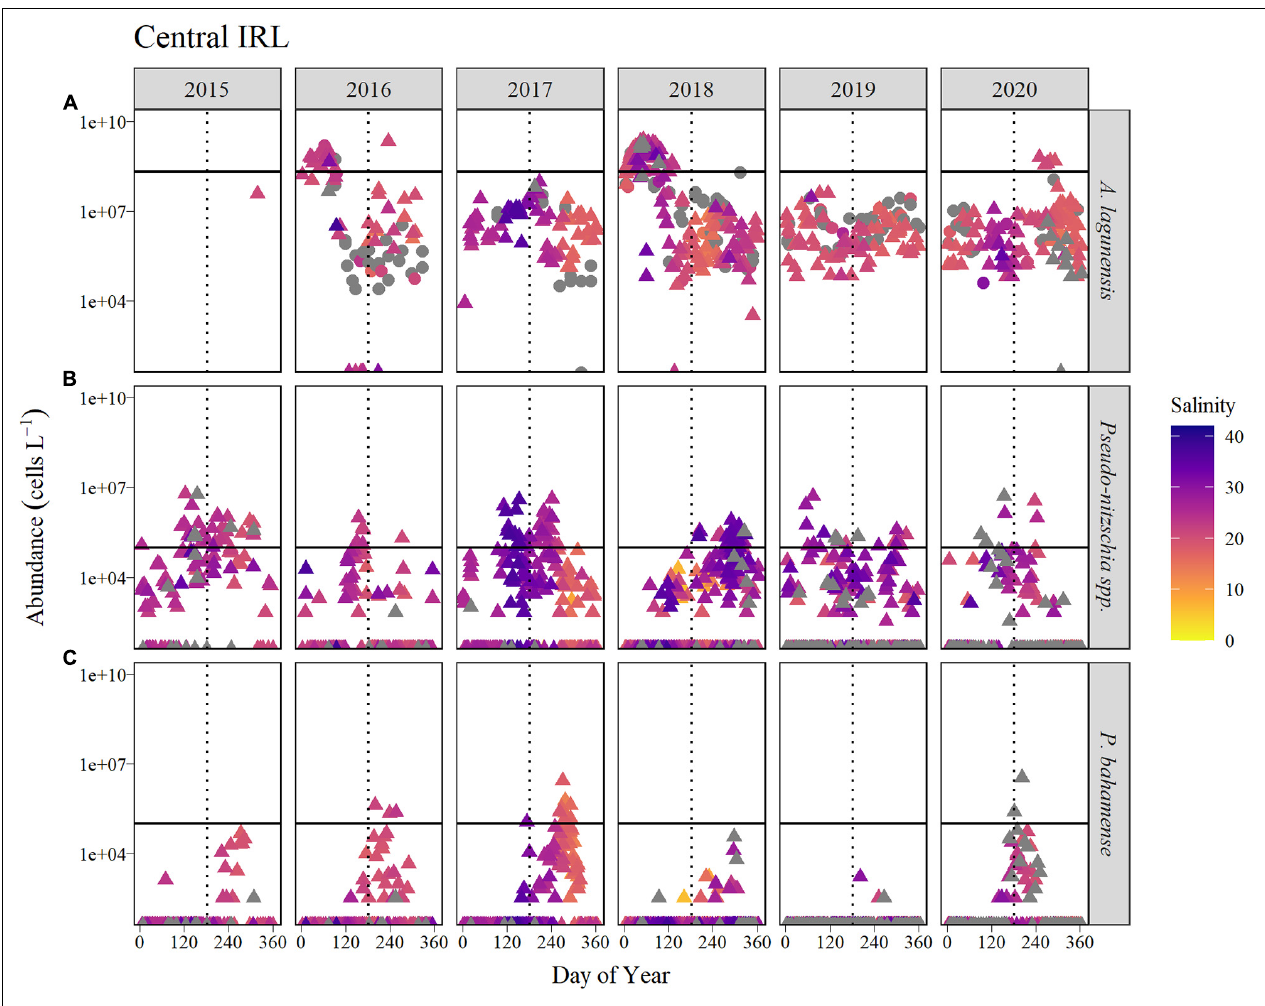
FIGURE 6 | Time course of abundance of (A) A. lagunensis cells, (B) Pseudo-nitzschia spp., and (C) P. bahamense presented on a logarithmic scale for the Central IRL sub-basin for the years 2015 to 2020 (horizontal panels). Symbol color indicates salinity in corresponding discrete samples, shown as a gradient from the lowest salinities (orange) to the highest (blue). Gray symbols represent samples in which no discrete salinity was recorded. For A. lagunensis , abundance was determined by FWC-FWRI microscopic enumeration (filled triangles) and immunofluorescence flow cytometry (filled circles). The solid horizontal line indicates the bloom levels for each taxon ( A. lagunensis = 2 × 10 8 cells L − 1 , Pseudo-nitzschia spp., and P. bahamense = 10 5 cells L − 1 ). The vertical dotted line represents JD 182 (July 1, non-leap